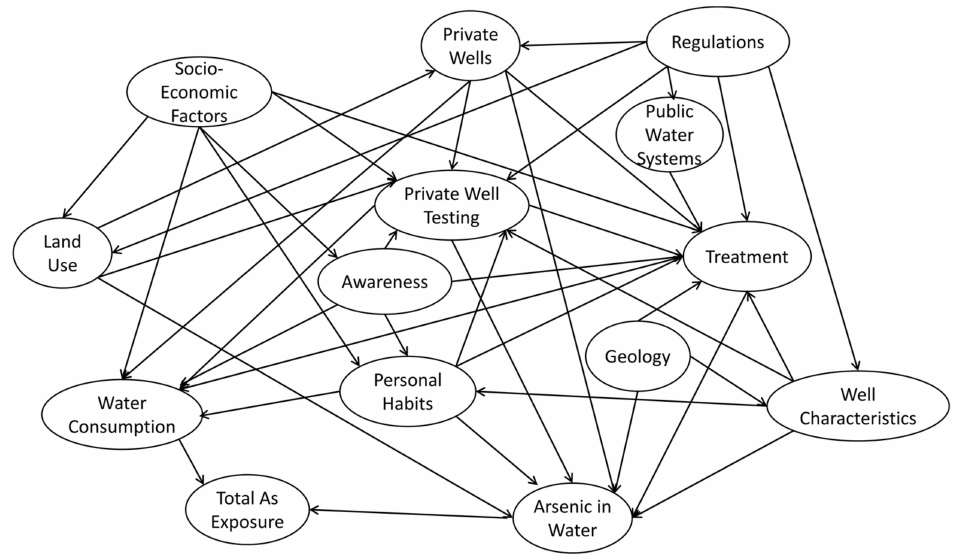
Figure 4. Additional expert model focused on exposure risk from drinking